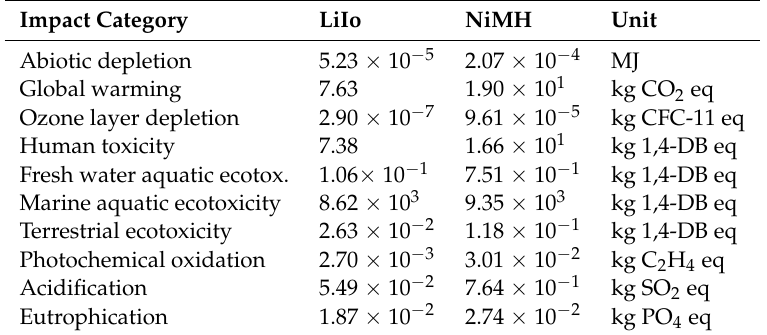
Table 5. Comparative impacts of LiIo and NiMH batteries by the CML midpoint